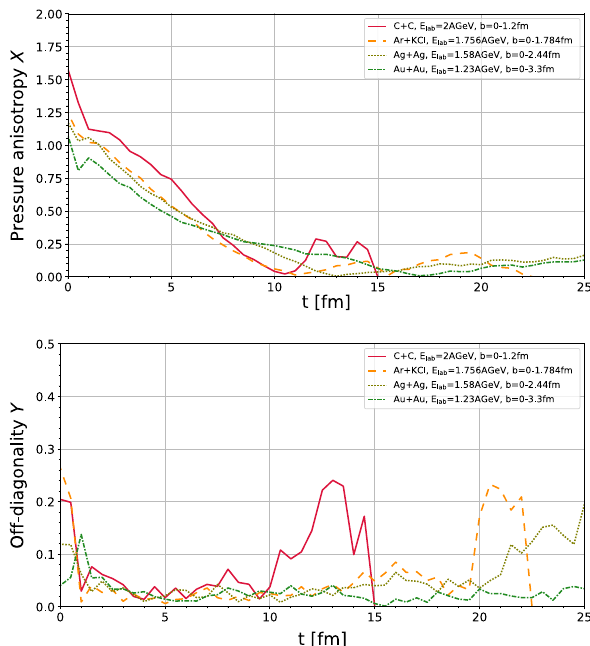
Fig. 8 Time evolution of the pressure anisotropy X and of the off- diagonality Y in the center of the system for the reactions listed in